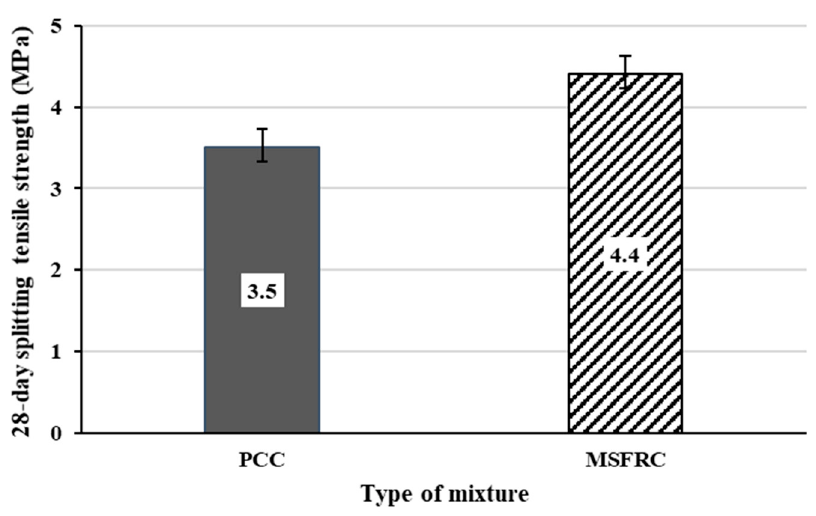
Figure 7. Splitting tensile strength test results.